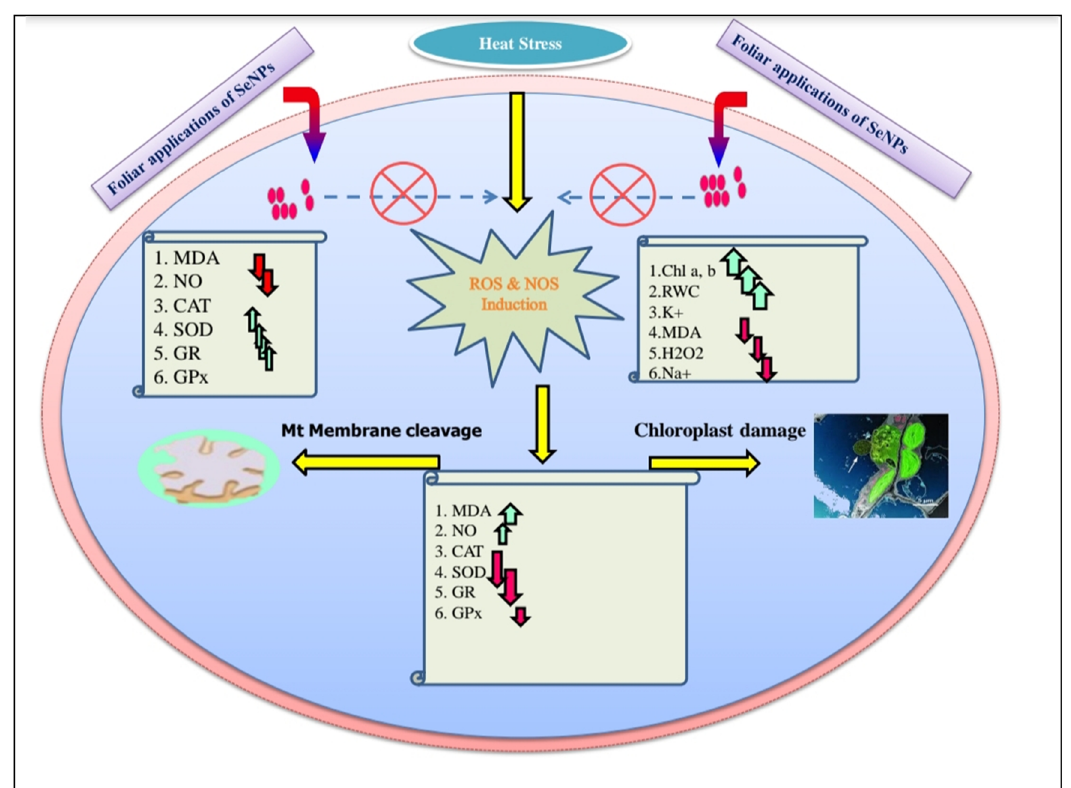
Figure 3: Possible heat tolerance mechanism in plants exposed to biogenic SeNPs. Upward arrows show an increase and downward arrows show a decrease in the respective